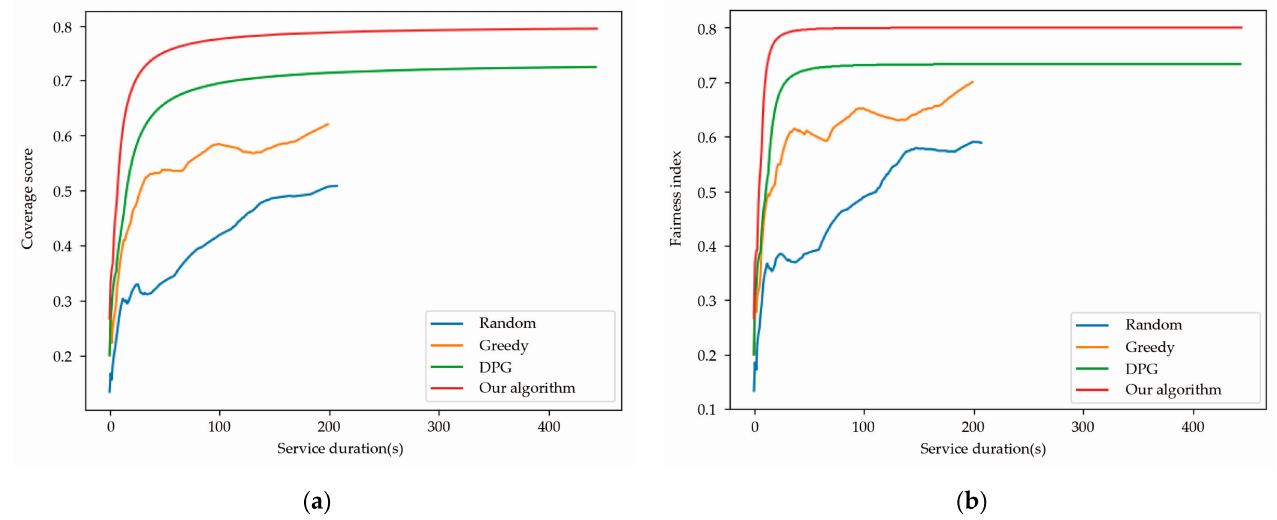
Figure 9. ( a ) Coverage score trend changing with the number of service duration increases; ( b ) fairness index trend changing with the number of service duration